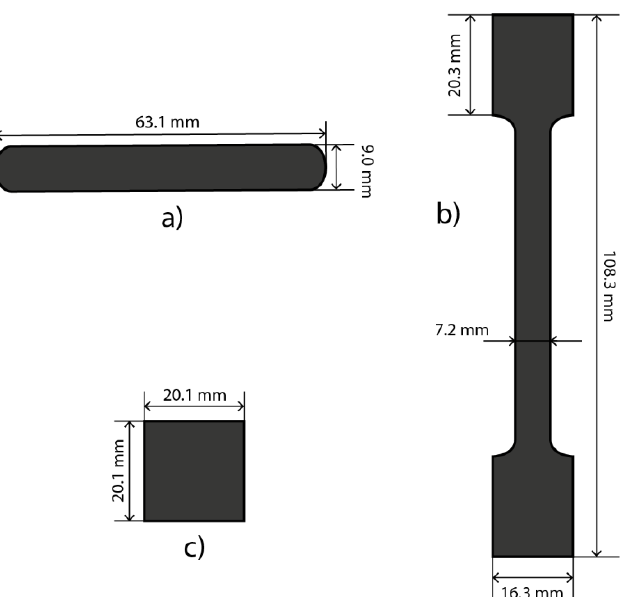
Figure 2. Dimensions of the samples for the measurement of ( a ) flexural strength, ( b ) tensile strength, and ( c ) hardness.